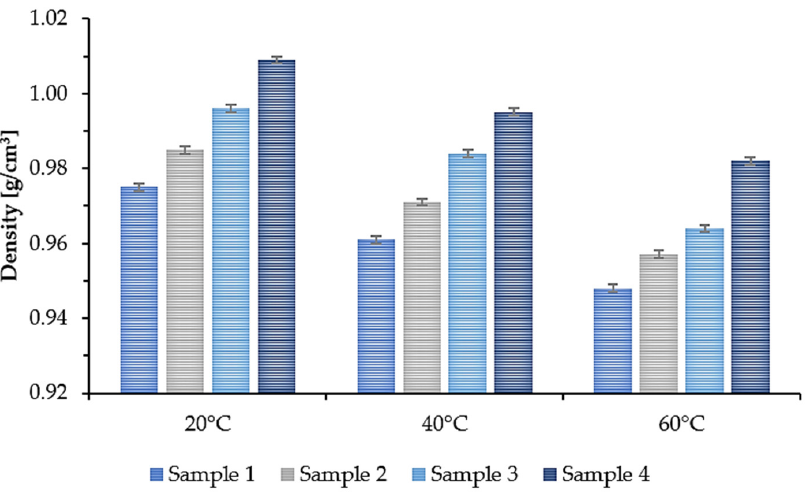
Figure 5. Density of epoxidized mixed esters (Samples 1–4) at 20, 40, and 60 °C.